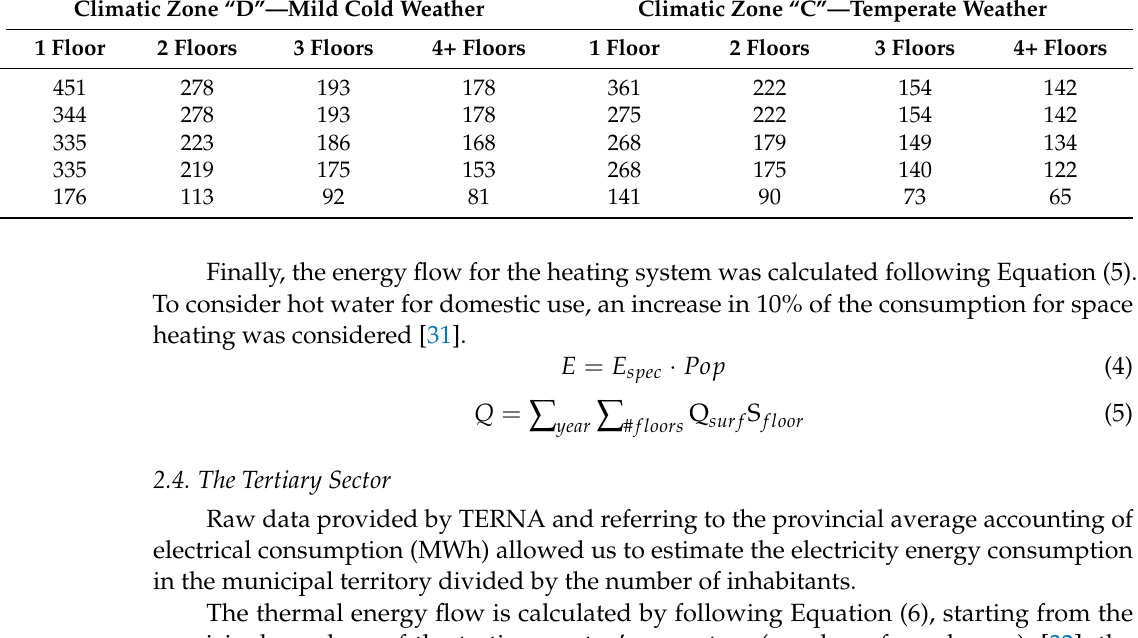
Table 3. Value of energy demand ( Q surf , MWh/m 2 ), distributed by number of floors above ground and construction year, and differentiated by climatic zone (C or D). kWh/m